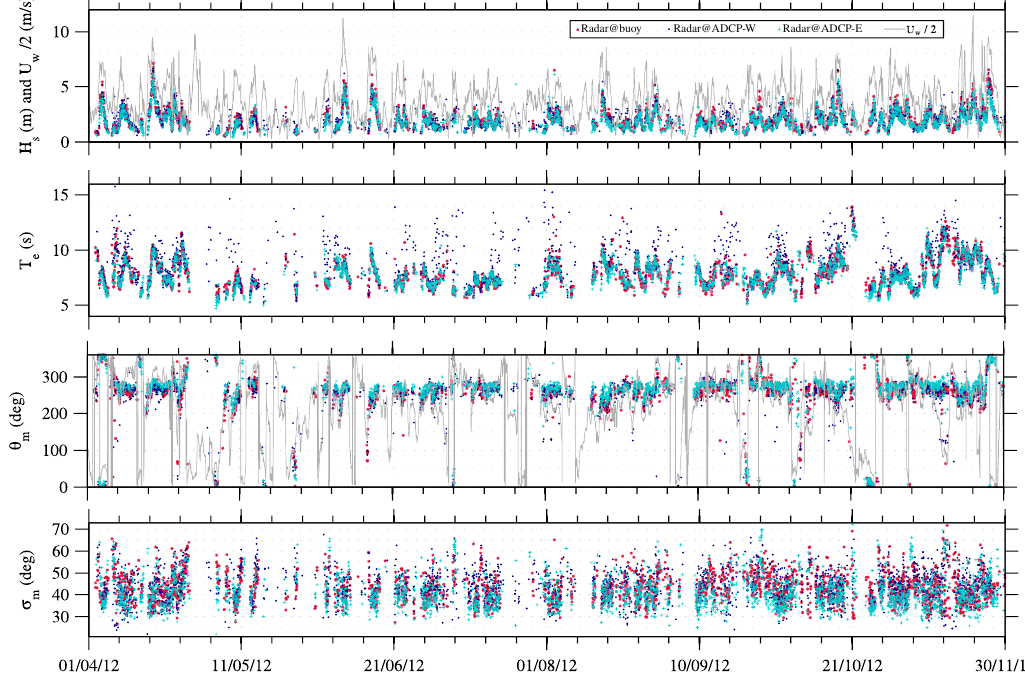
Figure 2. Radar wave parameters co-located with the wave buoy (red star), the ADCP-W (dark blue dots) and ADCP-E (light blue crosses) from April to November 2012 ( a ) significant wave height and wind speed (grey line); ( b ) energy period; ( c ) wave direction (direction of approach) and wind direction (grey line); and ( d ) mean directional spreading.